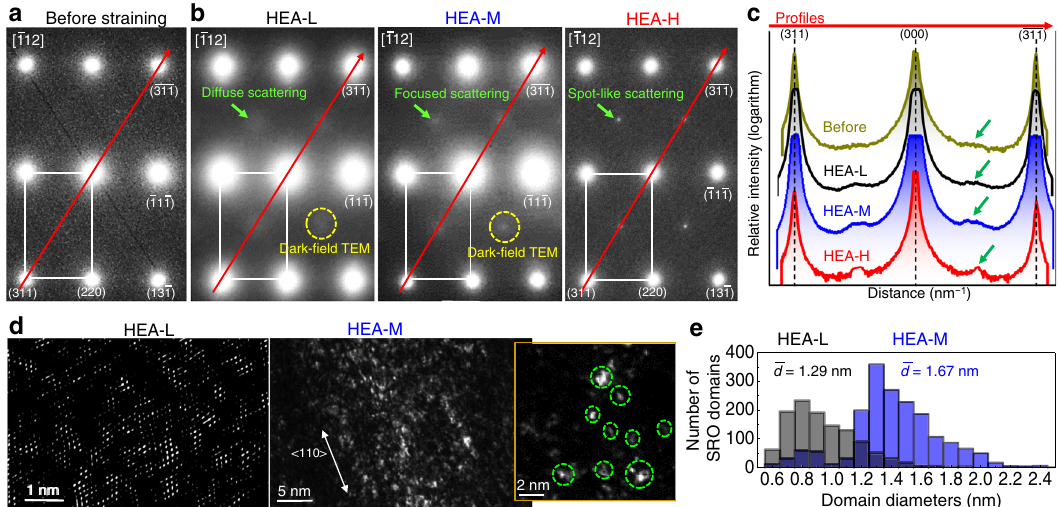
Fig.5|TEMdiffractionpatterns,intensityofMSRO-derivedextradiffusediscs, and the associated STEM images for different strain rates. Selected-area [ (cid:1) 112] TEM-EDPstakenfromindividualHEAgrains: a beforeand b aftertensilestrainingat different strain rates. These EDPs were acquired from the region of slip bands in each deformed specimen. Green arrows indicate periodic diffuse scattering along the {311} directions caused by MSRO. c Logarithmically scaled diffraction intensity along thered lines in a , b : thatis,the diagonallines acrossnormalfcc{311} spotsin the EDPs from HEA-L (black) and HEA-M (blue). The hump owing to MSRO- generated diffuse scattering in b is outlined by green arrows in the pro fi les. The measured diffraction intensity for the same alloy composition subjected to 77